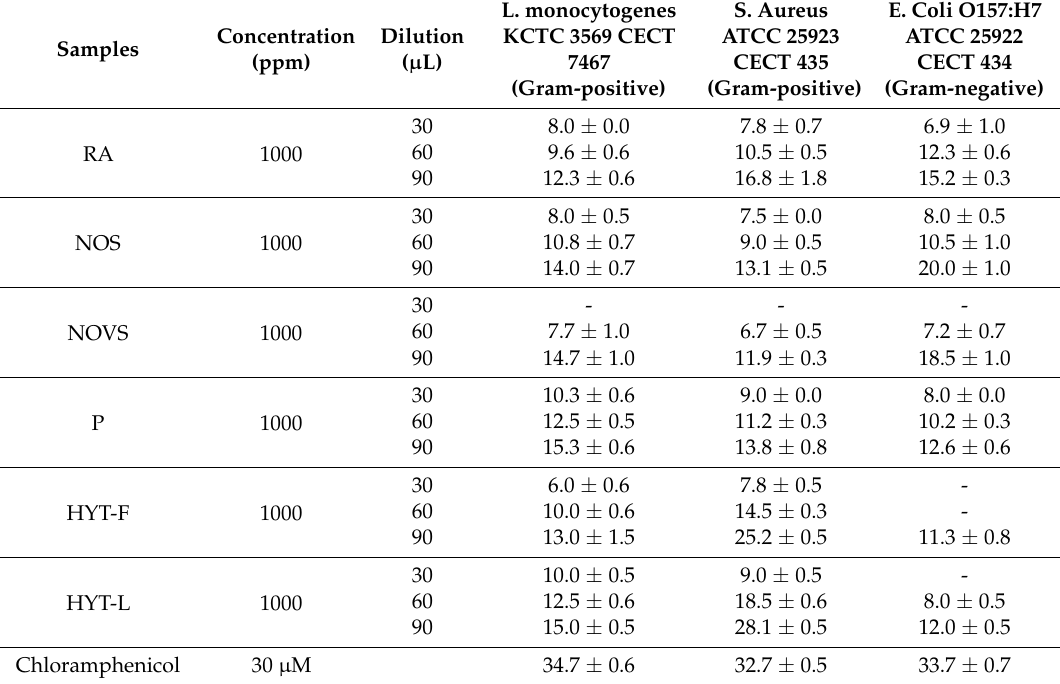
Table 3. Antimicrobial activity of natural extracts measured by the disc difussion method (mm ± SD).